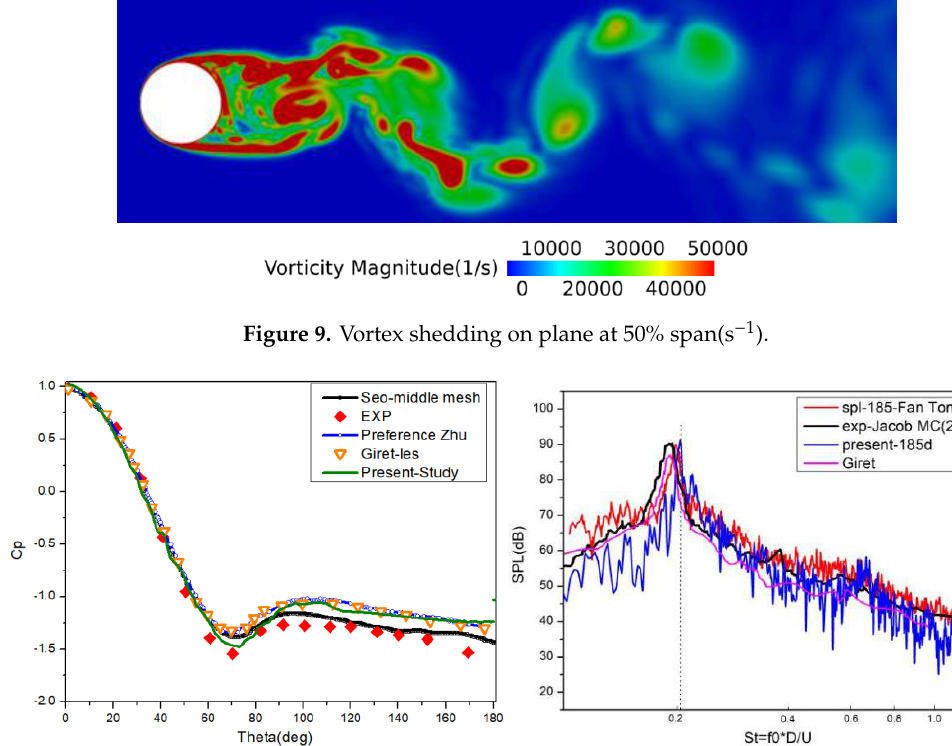
Figure 10. Validations of the Cp and SPL results at 185D (where f 0 . = 1508Hz).